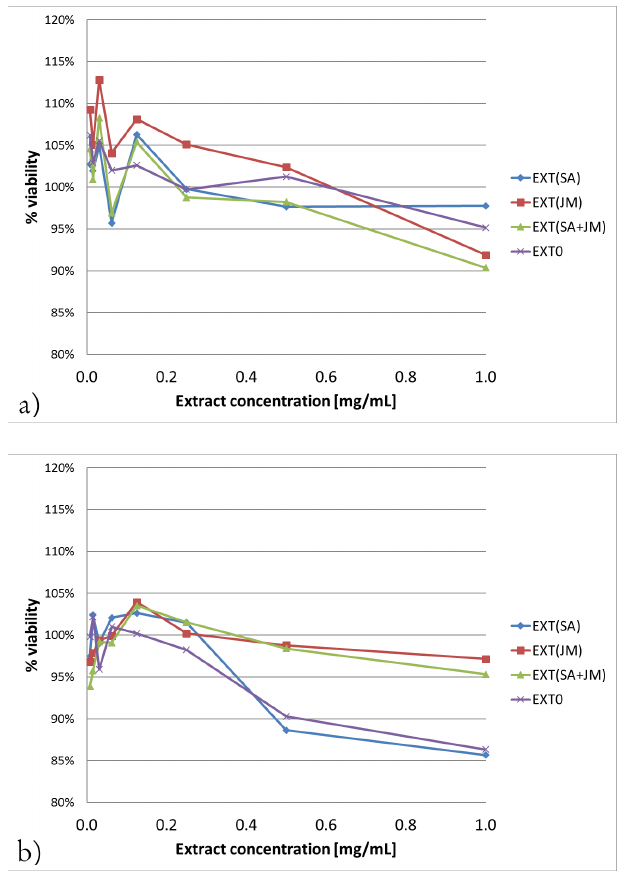
Figure 3. Results of two different cytotoxicity assays: ( a ) Neutral Red Uptake (NRU) ( b )